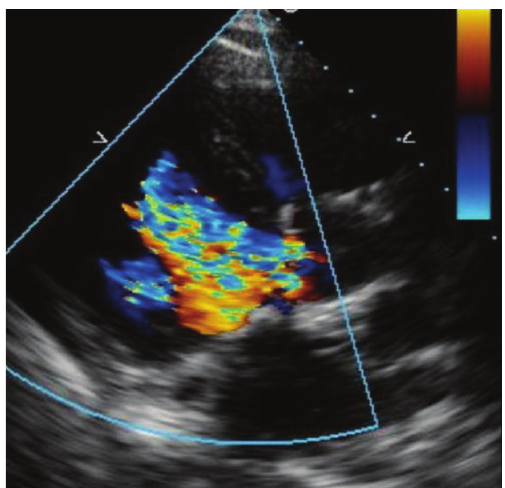
Figure 1: Transthoracic echocardiogram. Parasternal long-axis view reveals aortic regurgitation with both central and peripheral jets suggestive of valve perforation.